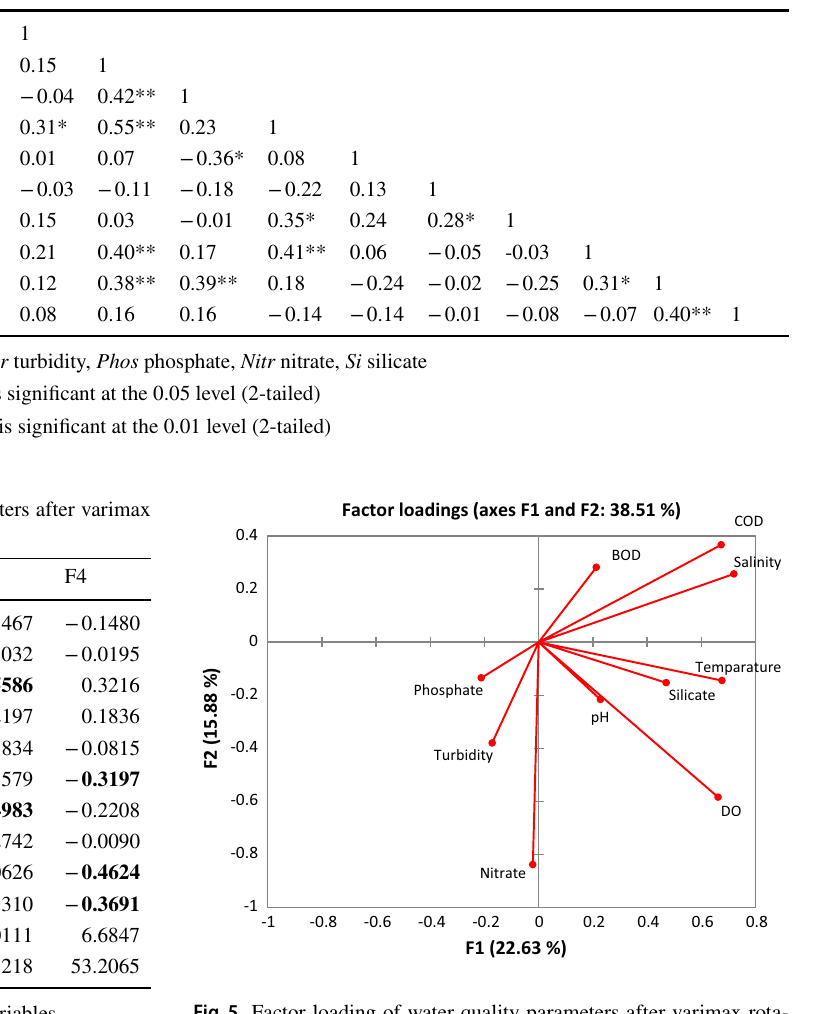
Bold values indicating the highest loading for the